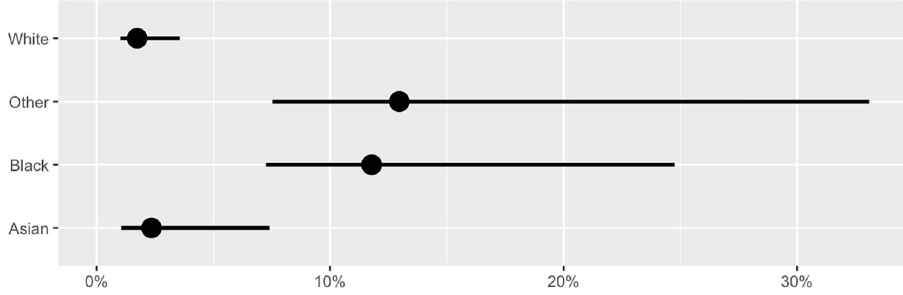
Fig 2. Estimated anti-SARS-CoV-2 seroprevalence across race group in King County in early-to-mid-August 2020. Points indicate estimates and lines indicate 95% confidence intervals.